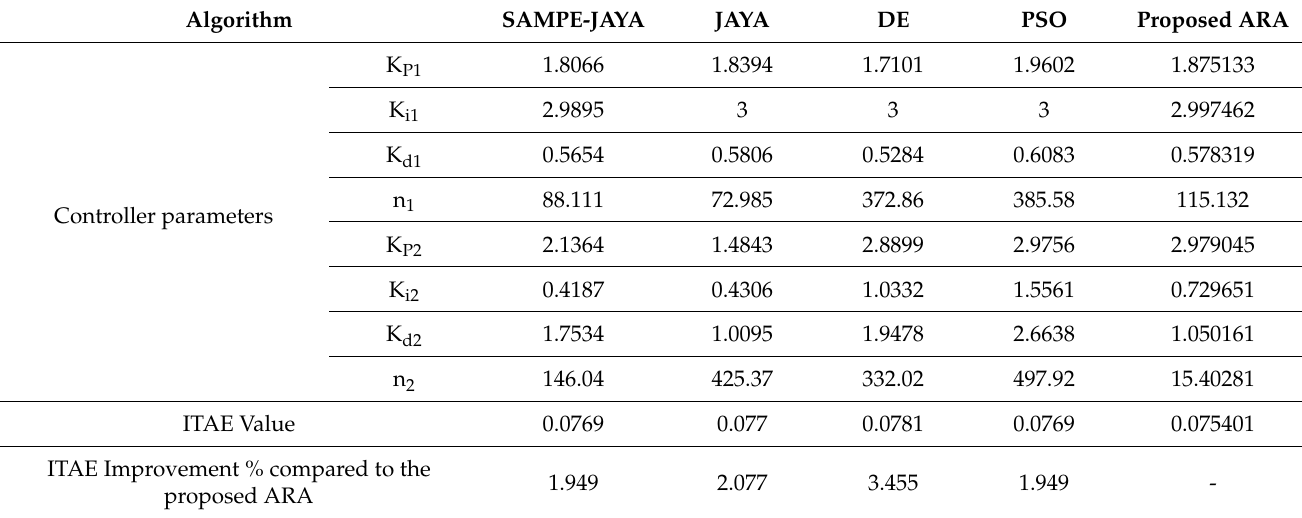
Table 1. Simulation results under Case Study